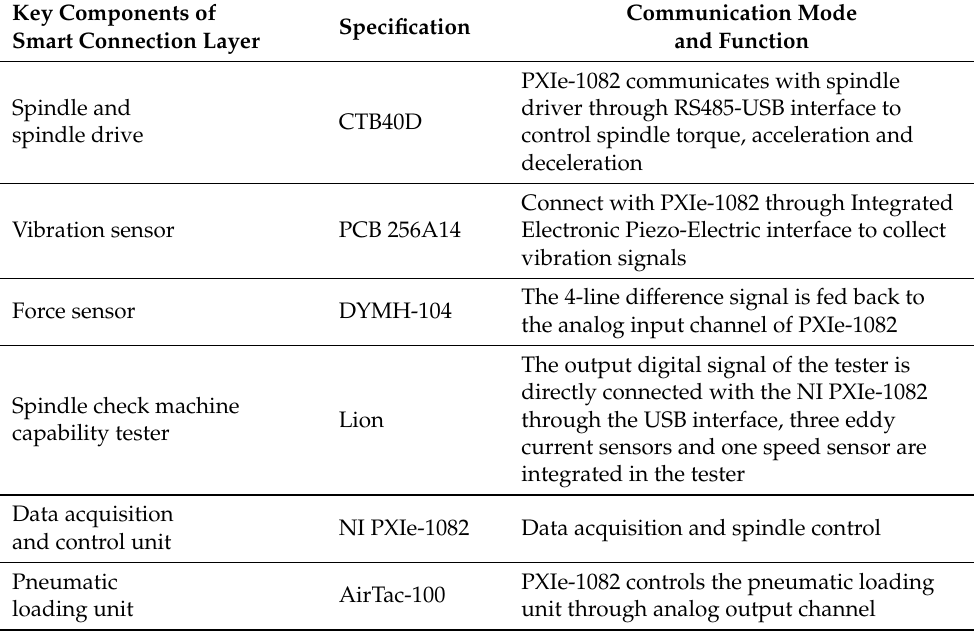
Table 4. Detailed description of the Smart Connection Layer